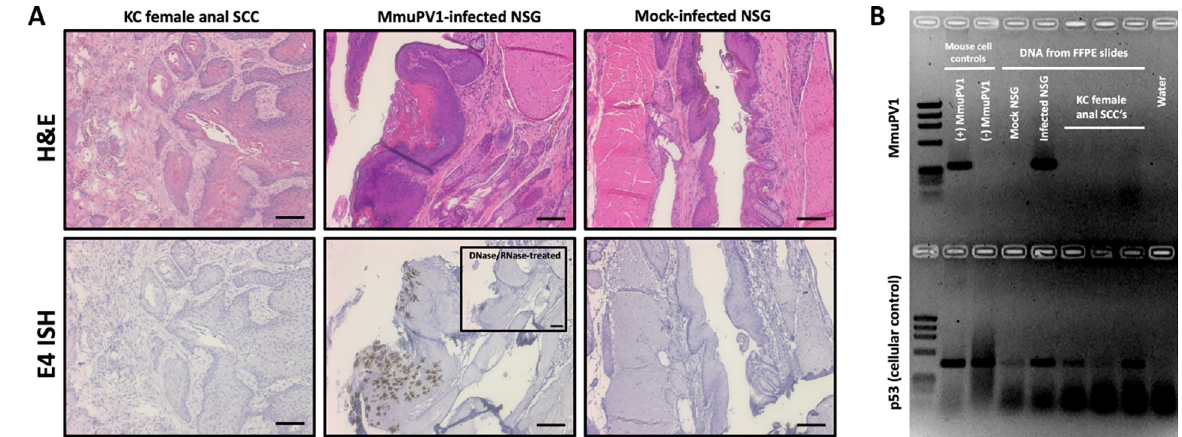
Fig 3. Anal squamous cell carcinomas in KC mice were negative for MmuPV1 infection. (A) No viral signatures were detected in representative anal tumors from KC mice stained via RNAScope ISH with a probe specific to the MmuPV1 E4 region of the genome. MmuPV1-infected and mock-infected Nod- scid IL2R γ null (NSG) mouse anal tissues were included as positive and negative controls, respectively. Scale bars equal 100 μ m. (B) DNA was recovered from FFPE slides of representative KC female anal squamous cell carcinomas and MmuPV1-infected and mock-infected anal tissues, and PCR was performed using primers specific to the MmuPV1 genome. KC lesions were negative for MmuPV1 DNA.